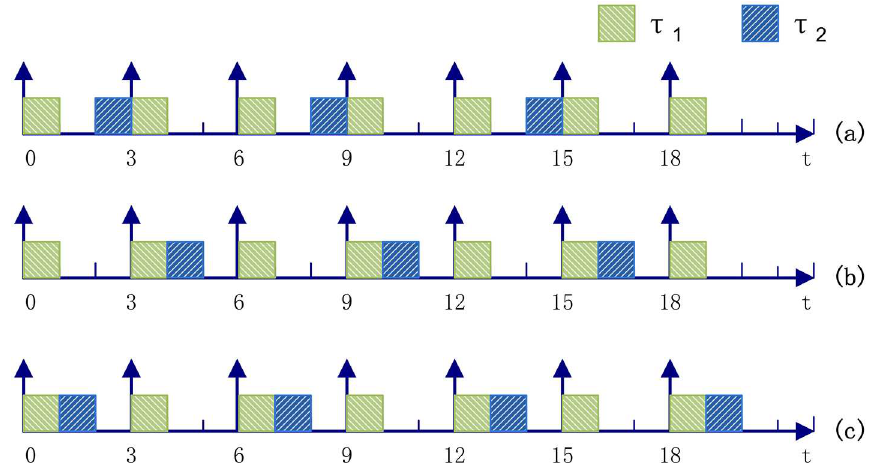
Fig 2. Non-overlapping execution of two periodic partitions on the sameprocessor.